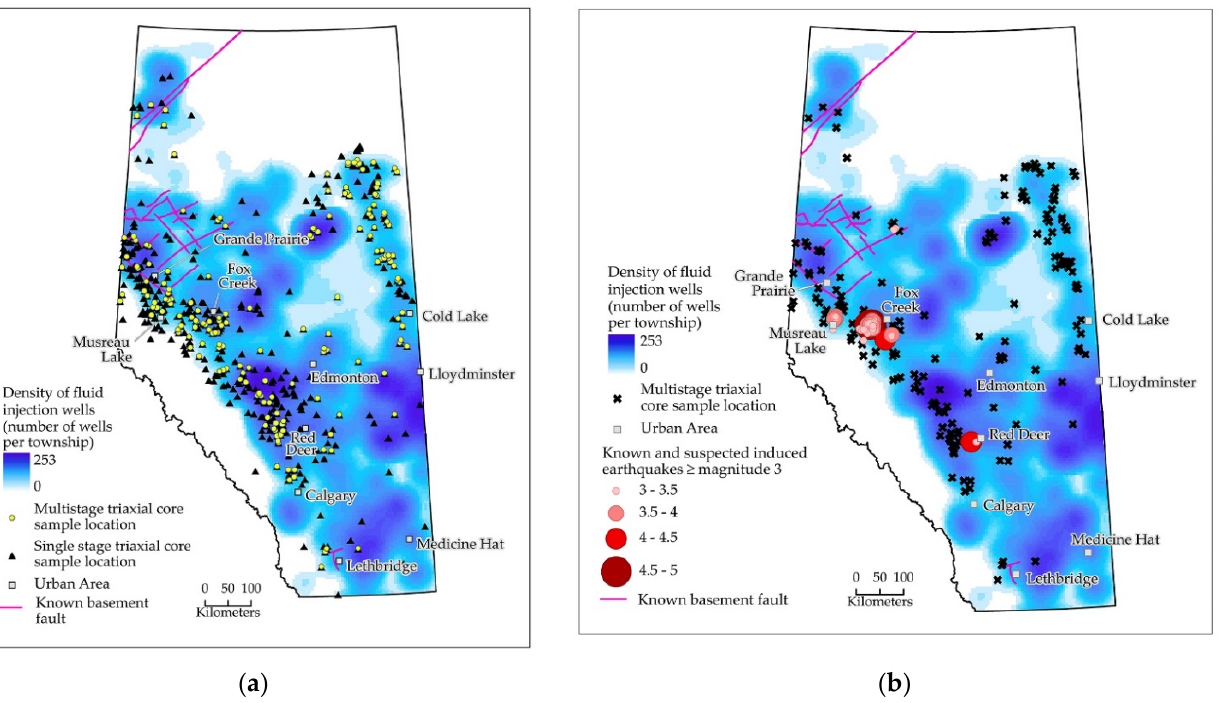
Figure 1. ( a ) Location of (approximately 600) triaxial core samples (triangles), (approximately 200) multistage triaxial samples (circles) and density of approximately 33,000 wells reporting some fluid injection over the period 1960–2021. ( b ) Location of known and suspected significant fluid-injection- induced earthquakes that have occurred in the Alberta Basin to date. Known regional basement faults are indicated by red lines. Table 1. Summary of the number of multistage triaxial tests used in this analysis and the source